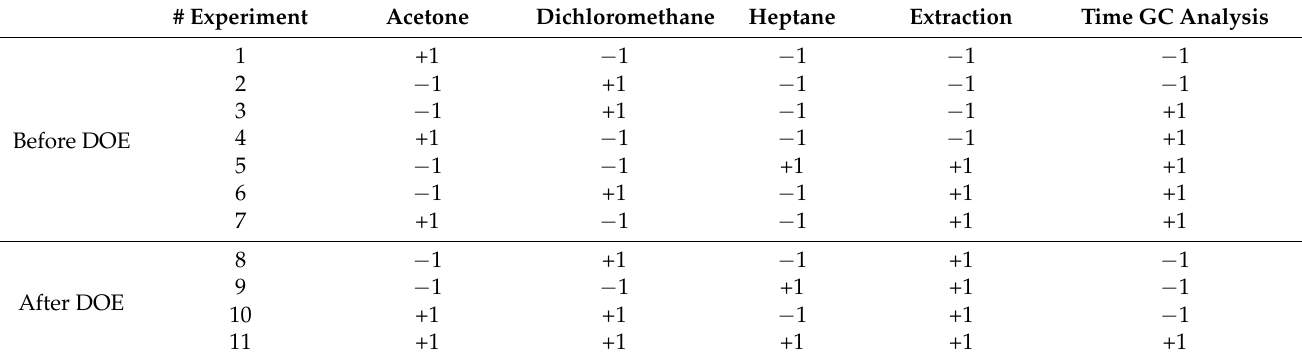
Table 2. Experimental parameters: where for acetone, dichloromethane, heptane +1 is yes, − 1 is no; for extraction +1 is sonication process, − 1 is Soxhlet process; for time of GC analysis +1 is 30 min, − 1 is 24 min.